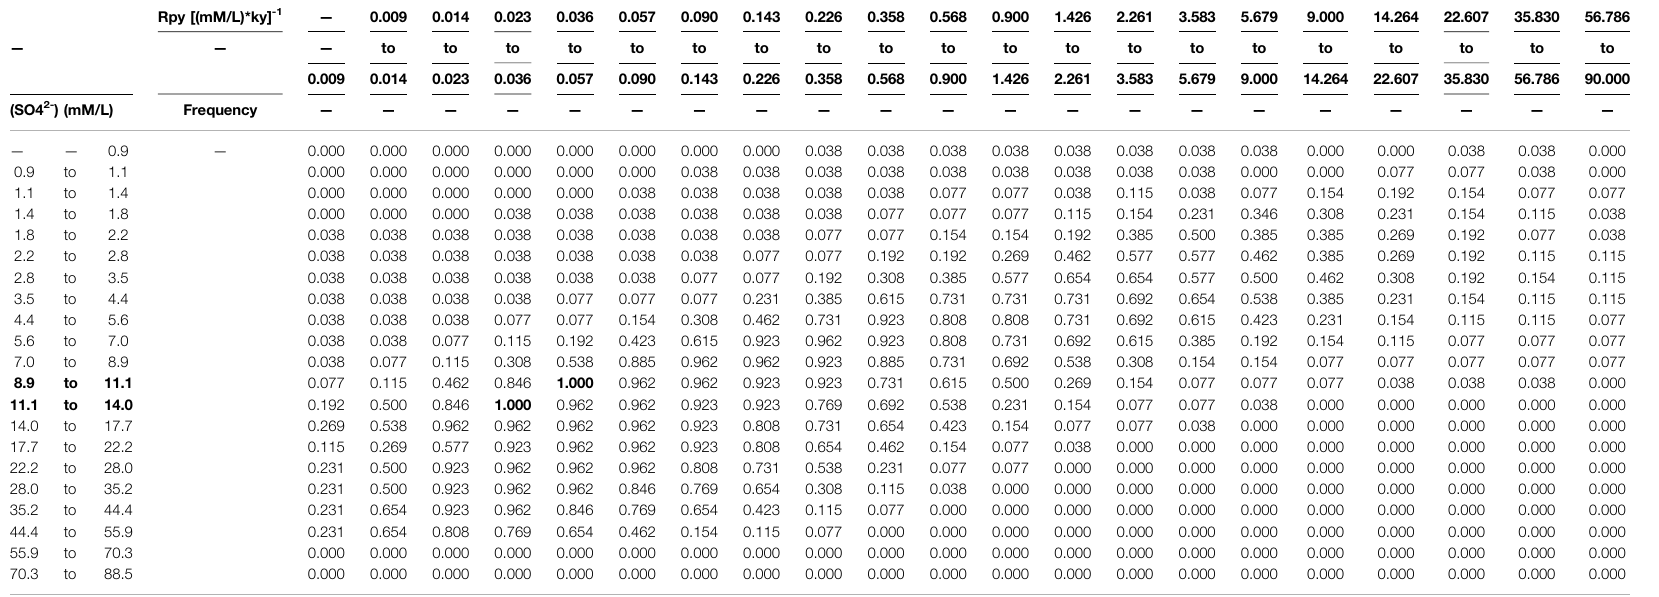
TABLE 3 | Frequency map on seawater sulfate concentration and redox condition. Frequency (cid:1) 1 (highlight by overstriking word) indicates possible seawater sulfate concentration 8.9 – 14.0 mM (highlight by overstriking word) for all samples. Rpy [(mM/L)*ky] -1